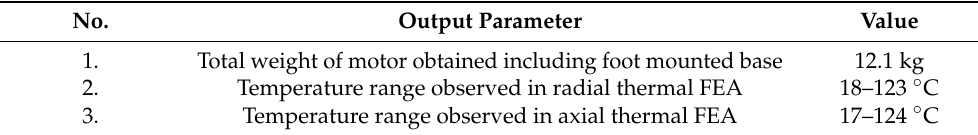
Table 10. Observations for water-cooled motor with aluminum (Alloy 195 cast) casing.